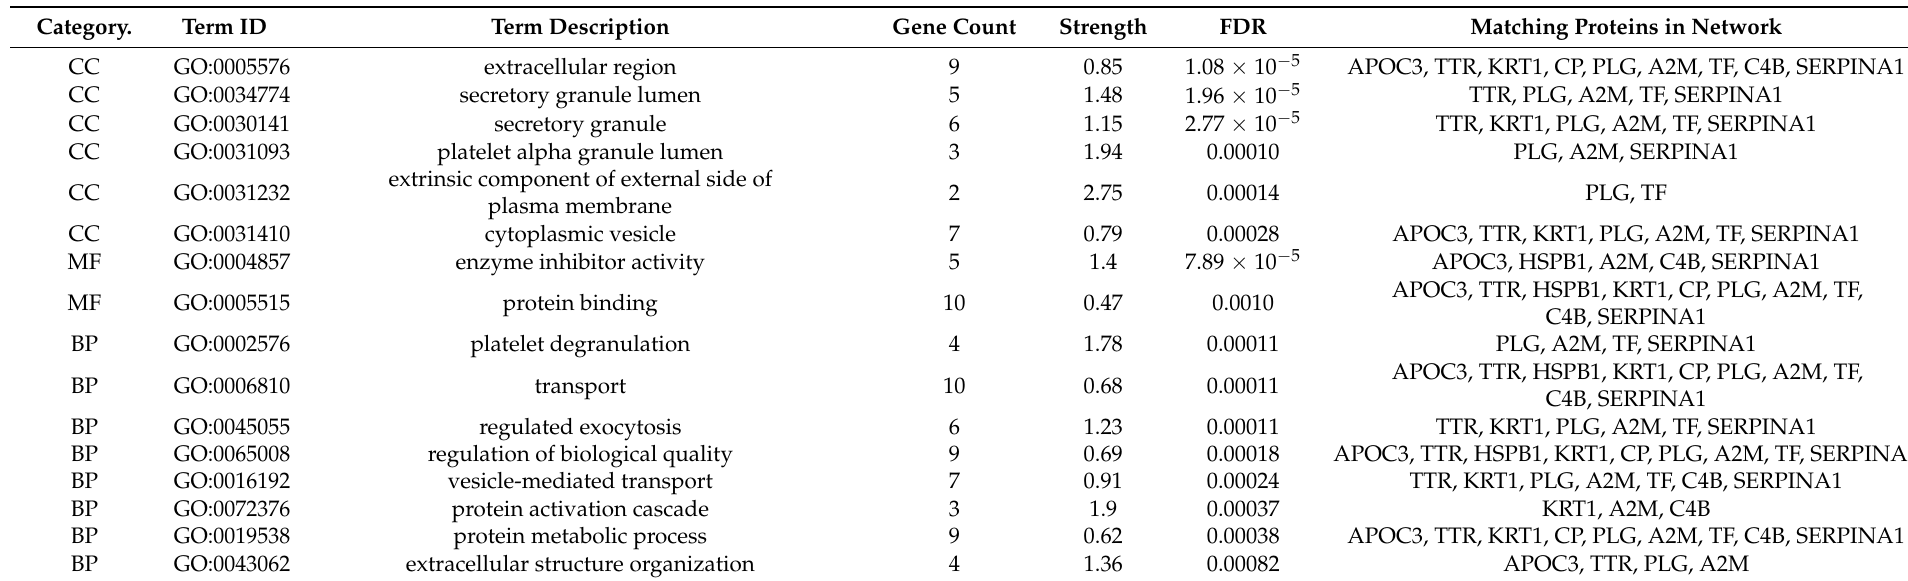
Table 6. The most significant GO terms within cellular component (CC), molecular function (MF), and biological process (BP) for CPT in CON. Category.